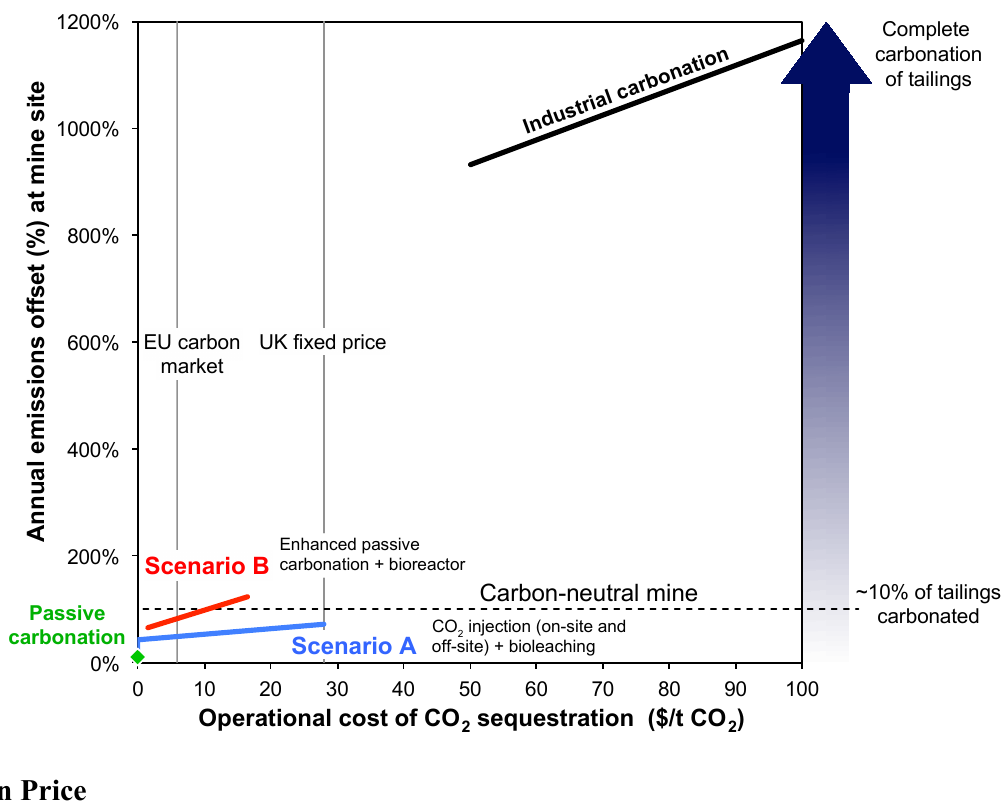
sequestration 2